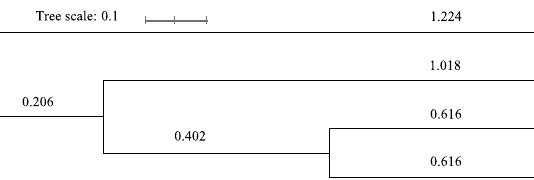
Figure 2. UPGMA phylogram for the four Sri Lankan ethnicities based on 16 X-STR data. The branch lengths are in the same units as those of the evolutionary distances used to infer the phylogenetic